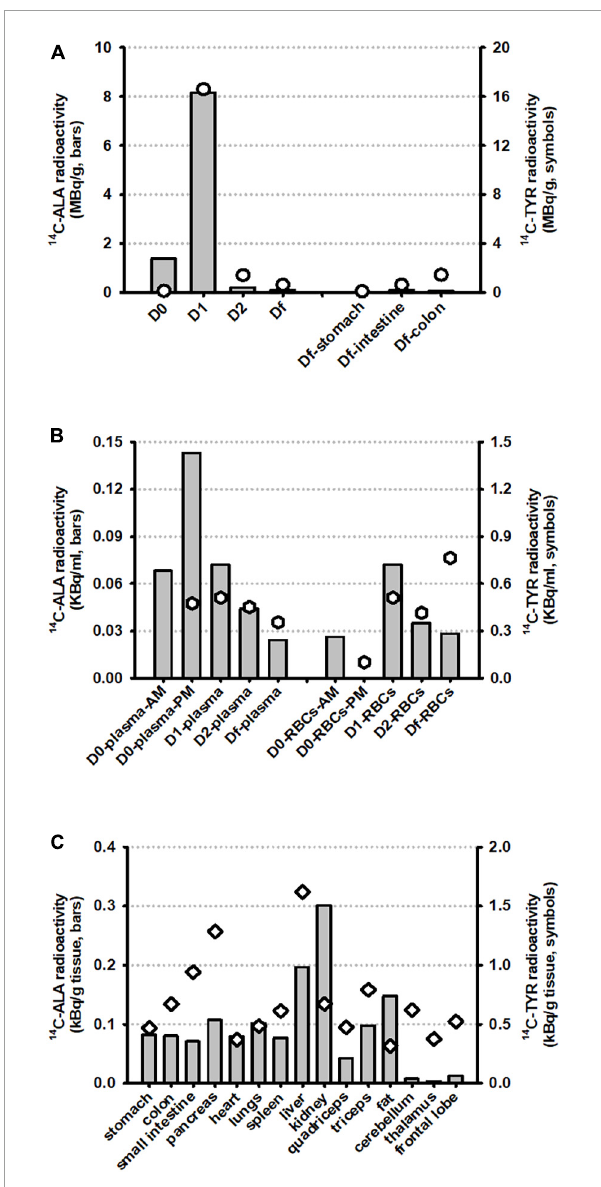
FIGURE3 Biodistribution of radioactivity from 14 C-ALA ( n = 1) and 14 C-Tyr ( n = 1) at a total dose of 20 MBq. The results are presented for (A) excreta samples (urine plus feces, taken on days 0, 1, 2, and F) and digesta samples, taken from the stomach, small intestine and colon on day F; (B) Blood plasma and blood cells (RBCs) on days 0, 1, 2, and F; and (C) Organ and tissue samples taken on day F.